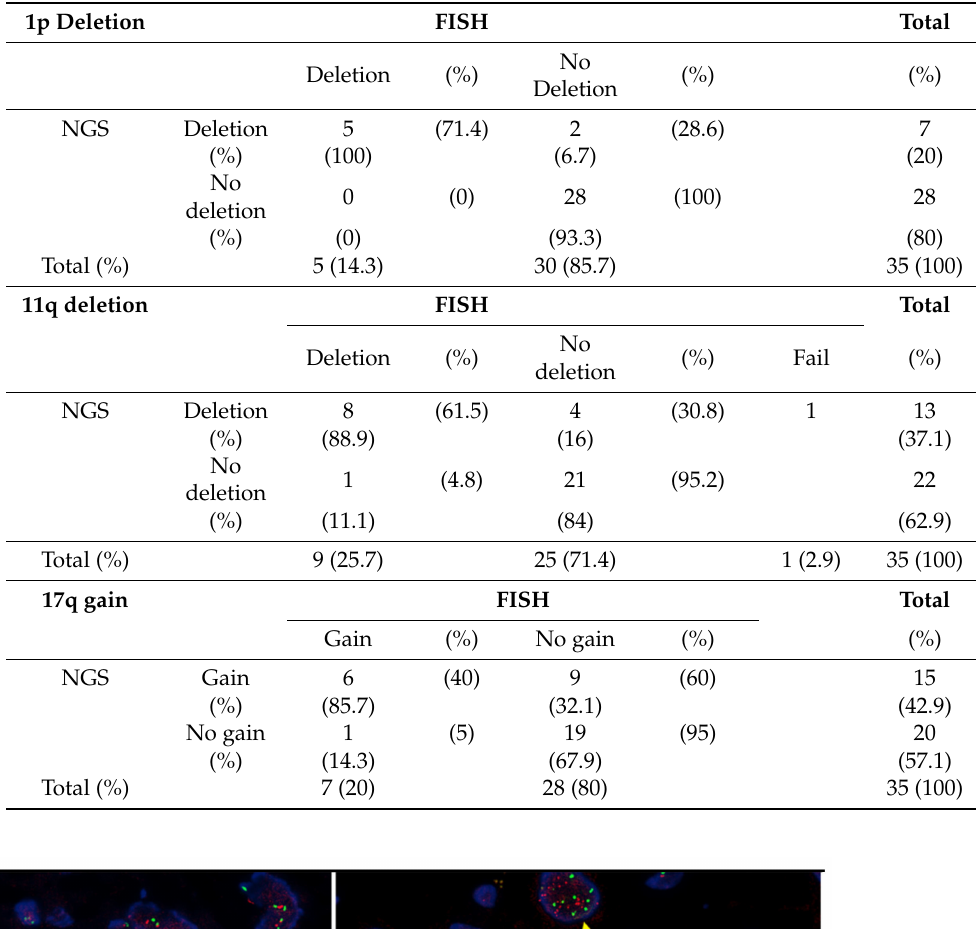
Table 2. Assignment of segmental chromosomal aberrations: NGS versus FISH.